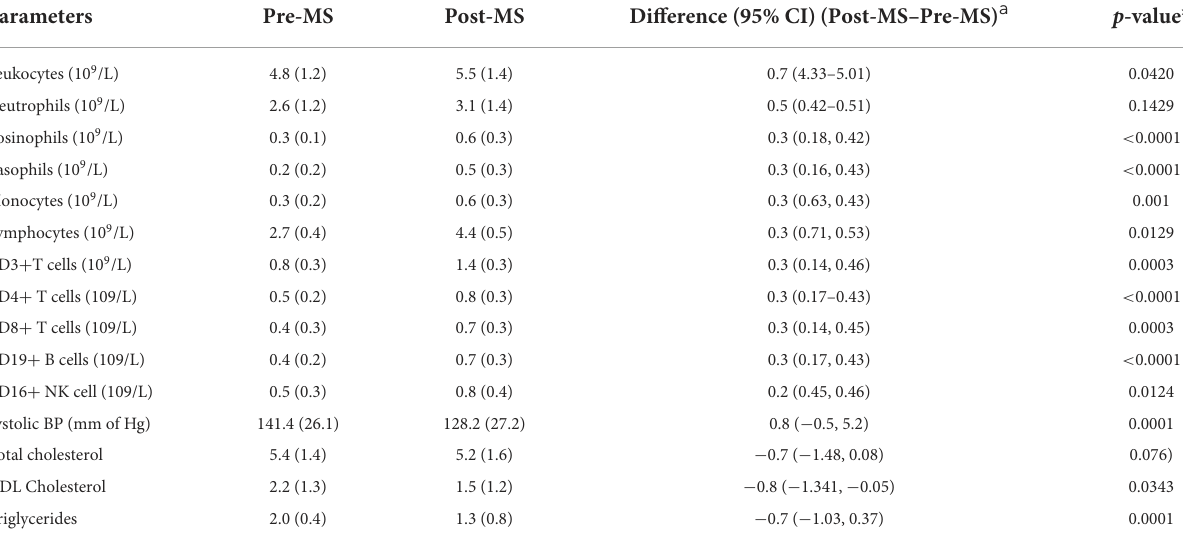
TABLE 2 Comparison of immunological and metabolic parameters between Pre-MS and Post-MS